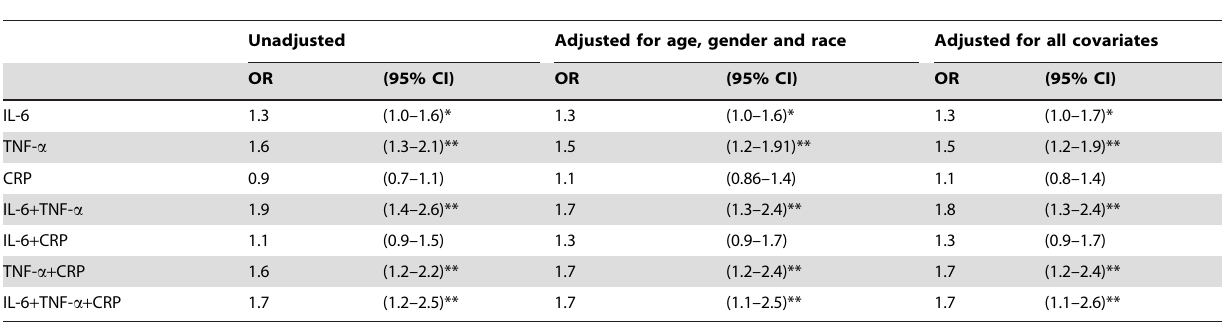
Table 2. Systemic inflammatory markers as predictors of short leukocyte telomere length.